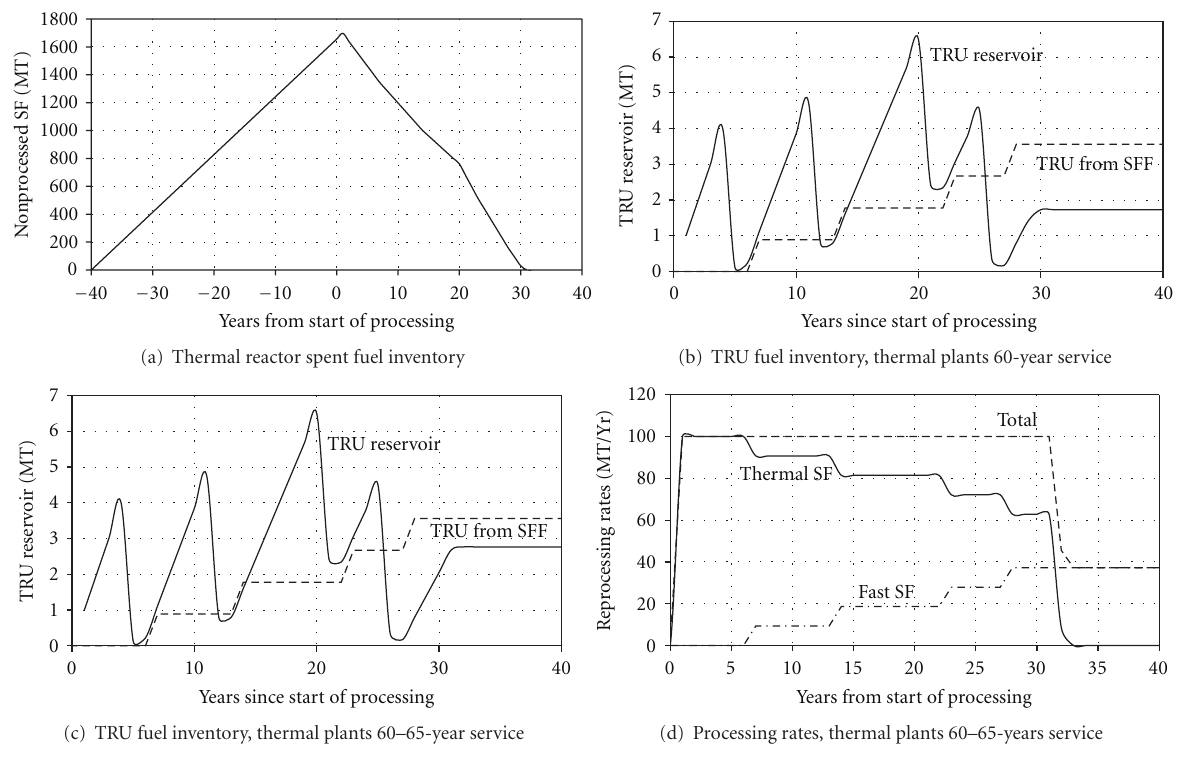
Figure 2: Site conversion from two thermal to four fast spectrum plants (BR =